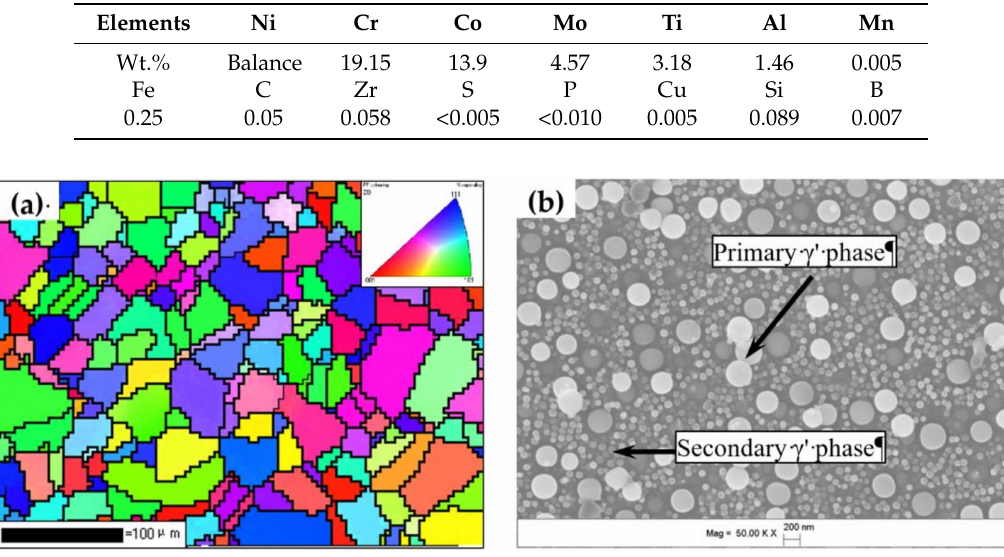
Table 1. Chemical composition of the Waspaloy.